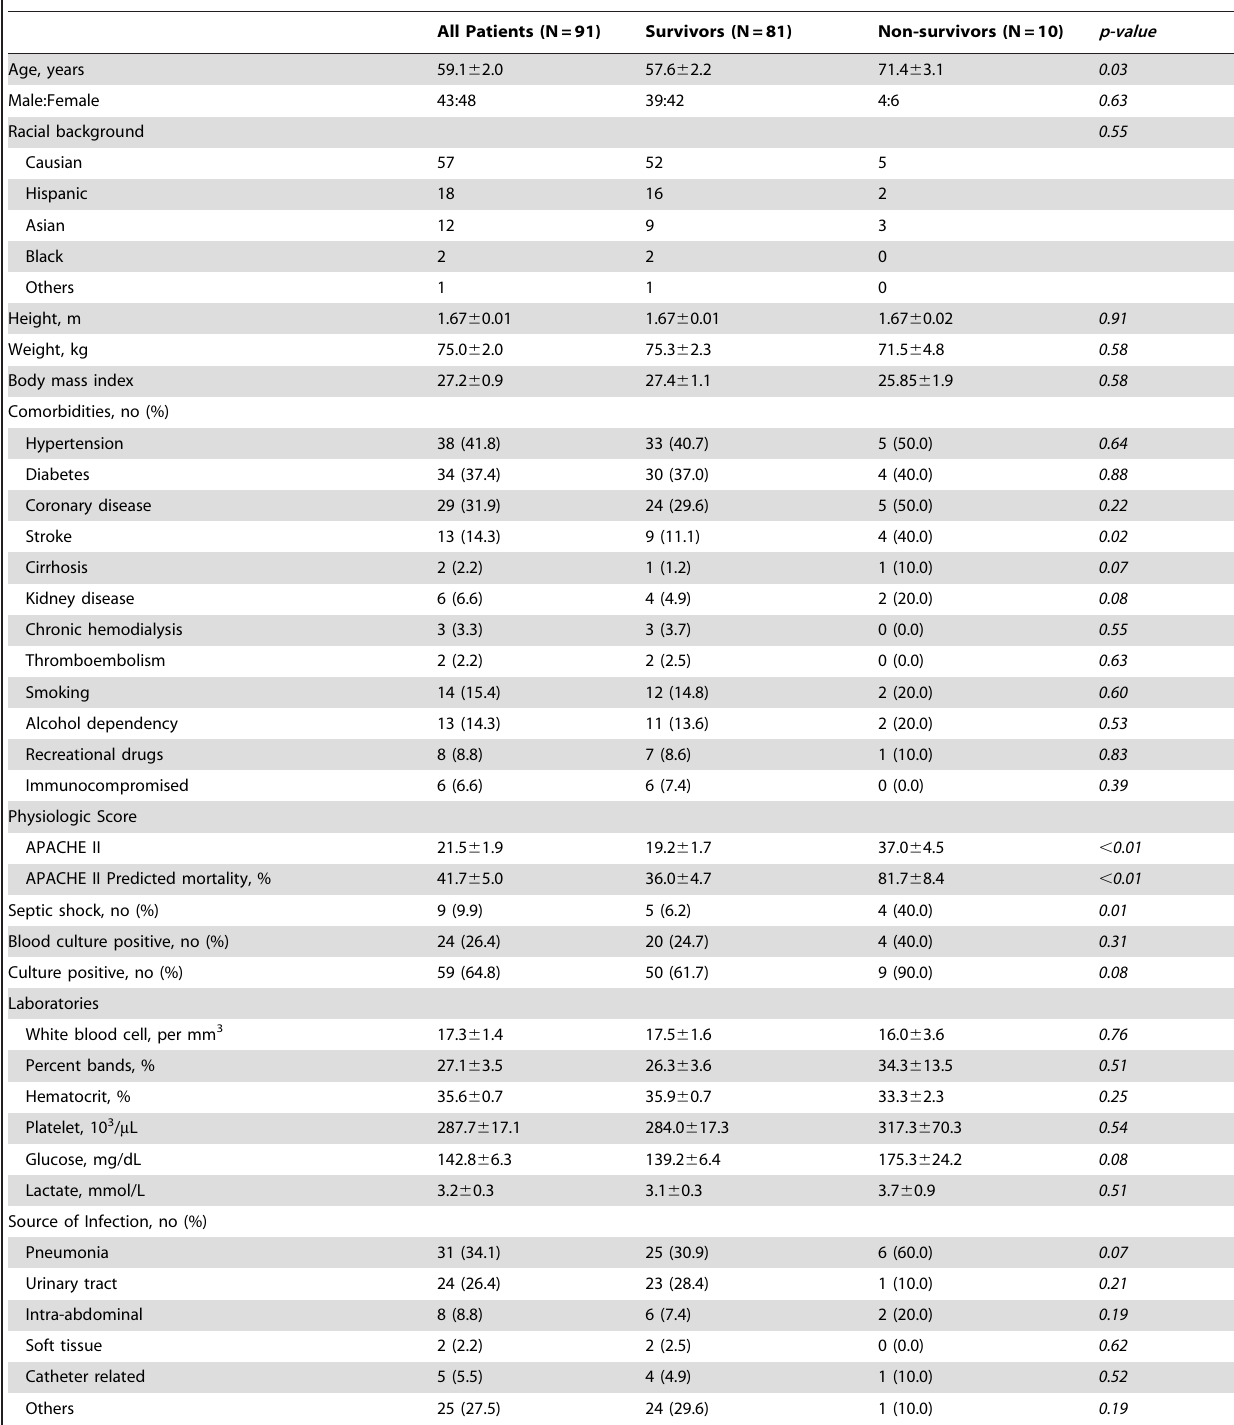
Table 1. Patient characteristics in survivors and